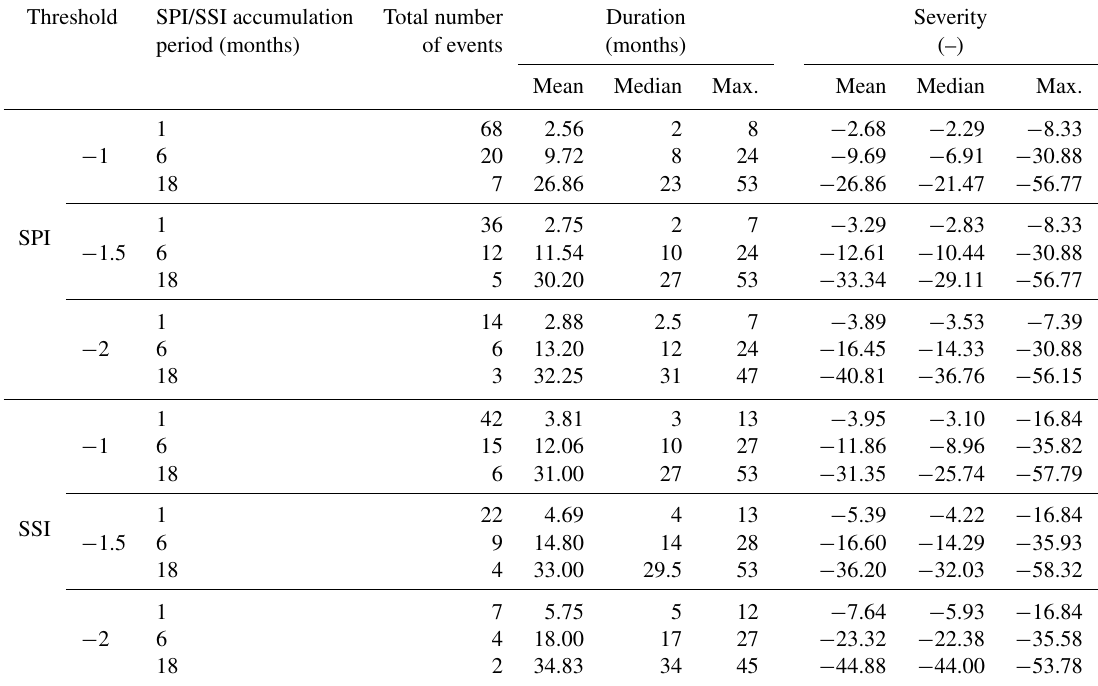
Table 2. Median drought characteristics calculated for selected SPI and SSI accumulation periods using thresholds of − 1, − 1.5 and − 2 for all